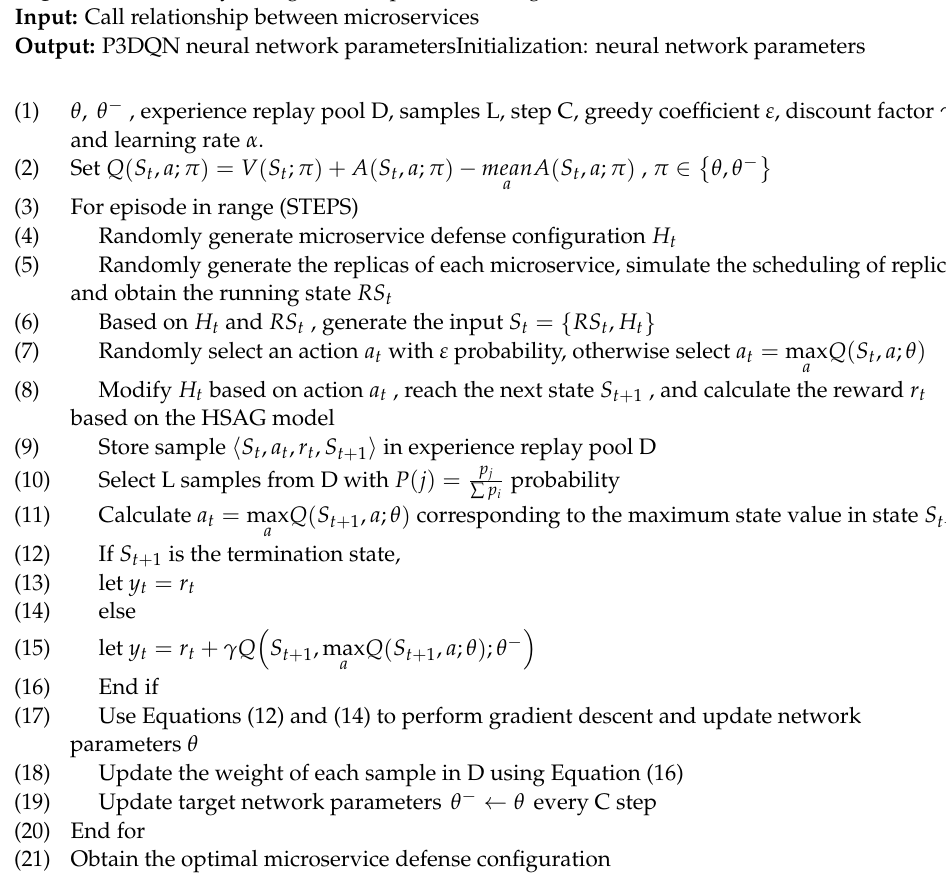
Algorithm 1: Security configuration optimization algorithm based on